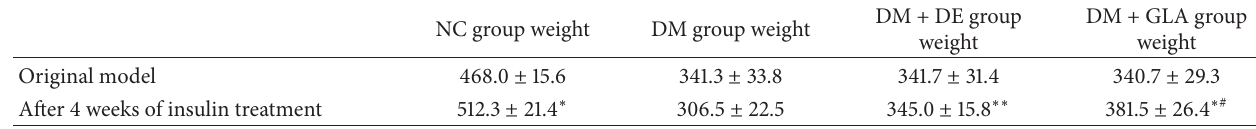
Table 2: Weight change of rats (g) after insulin treatment ( 𝑥 ± 𝑠